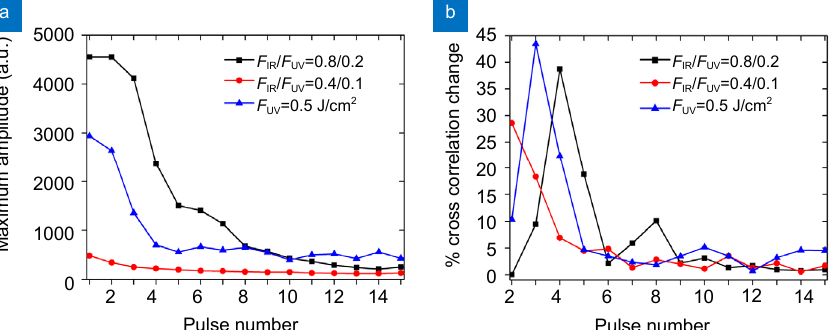
Fig. 4 | ( a ) Maximum amplitude and ( b ) Cross correlation maximum amplitude percentage change for irradiation with 355 nm and the simultane- ous use of two wavelengths in fluence ratio F IR / F UV =